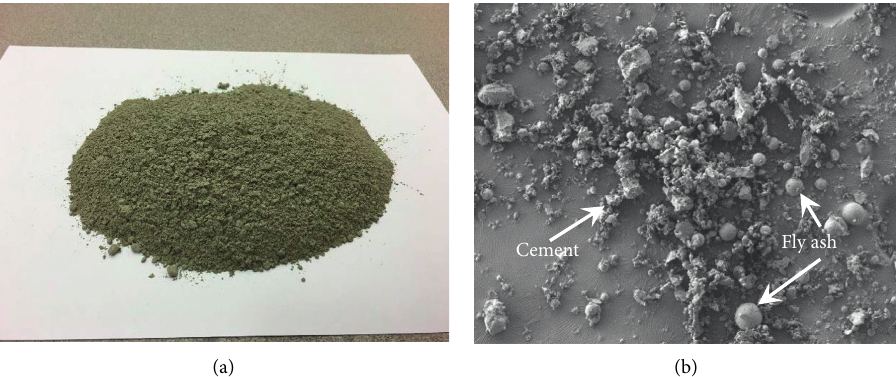
Figure 1: (a) Macrolevel and (b) microlevel photos of Portland-fly ash cement (prototype size of the image in (b) is around 2mm × 2 mm).